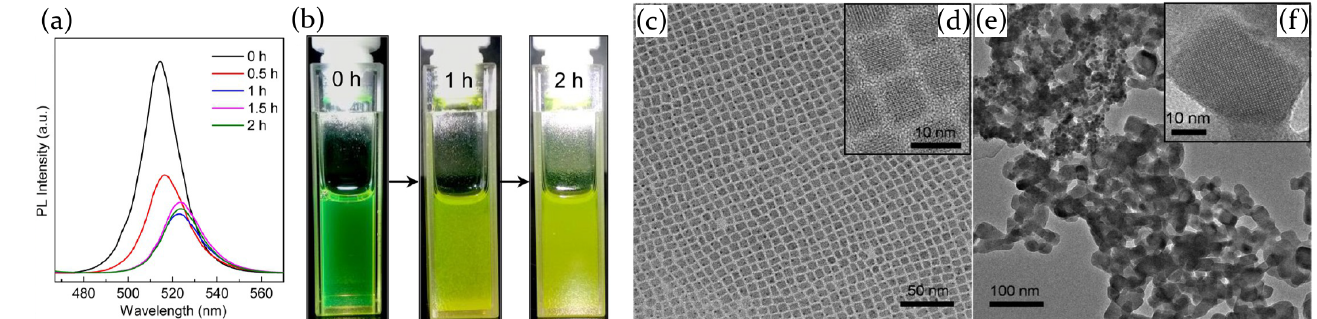
Figure 3. ( a ) PL emission spectra of the colloidal CsPbBr 3 toluene solution and ( b ) the optical images of the cuvette as a function of the illumination time (175 mW/cm 2 ). ( c ) Transmission electron microscope (TEM) and ( d ) high resolution transmission electron microscope (HRTEM) images of CsPbBr 3 -NCs. ( e ) TEM and ( f ) HRTEM images of the a CsPbBr 3 sample after 2 h of illumination. Adapted with permission from [62]. Copyright © 2017, American Chemical